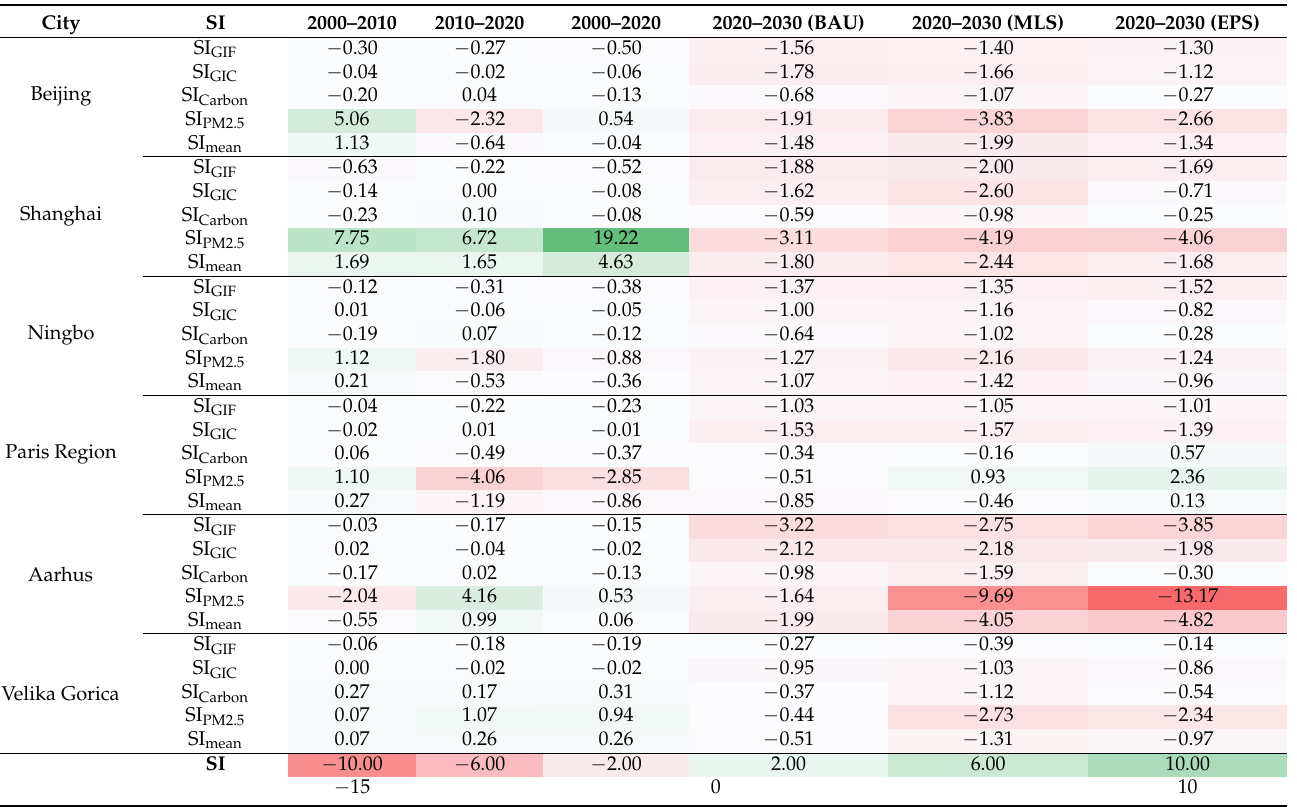
Table 2. Sensitivity index (SI) of the impact of land-cover change on GI and ESES changes in various stages. A higher SI value means that the indicator is more sensitive to land-cover change. When SI is greater than 0, it indicates that land-cover change has a positive effect on indicator change; otherwise, land-cover change has a negative effect on indicator change.